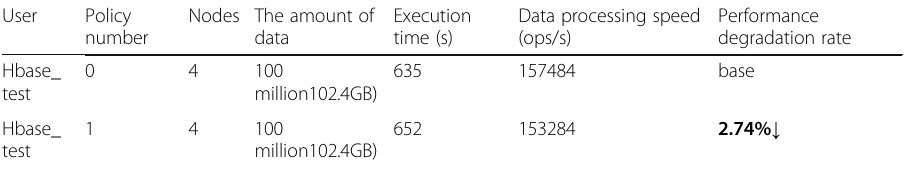
Table 5 Access control function test results using the new algorithm